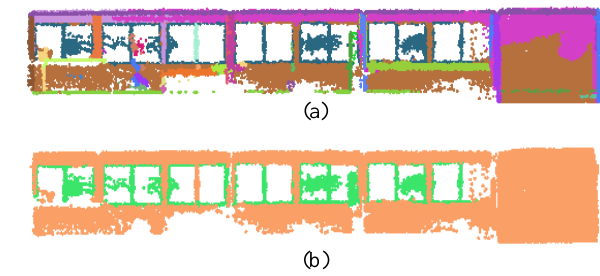
Figure 4. All segments from figure (a) are generalized in two surface patches in figure (b). For this example, we used parameters: d=40cm , θ=10 degree, d’=40cm. Noise of this data is 5-8